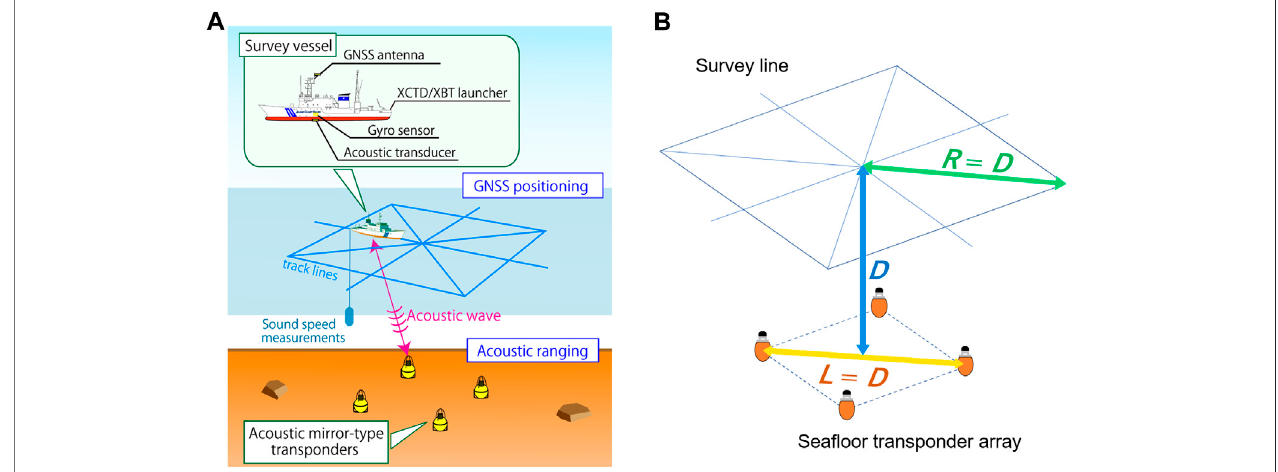
FIGURE 1 | Schematic images of the current GNSS-A observation system conducted by the Japan Coast Guard. (A) is the overview of the entire GNSS-A observation system,and (B) indicates thecon fi gurations ofthetransponderarray and thesurvey line.As shown in (B) , thesea fl oorsite depth (D), transponder arraysize (L), and survey line radius (R) are set to be